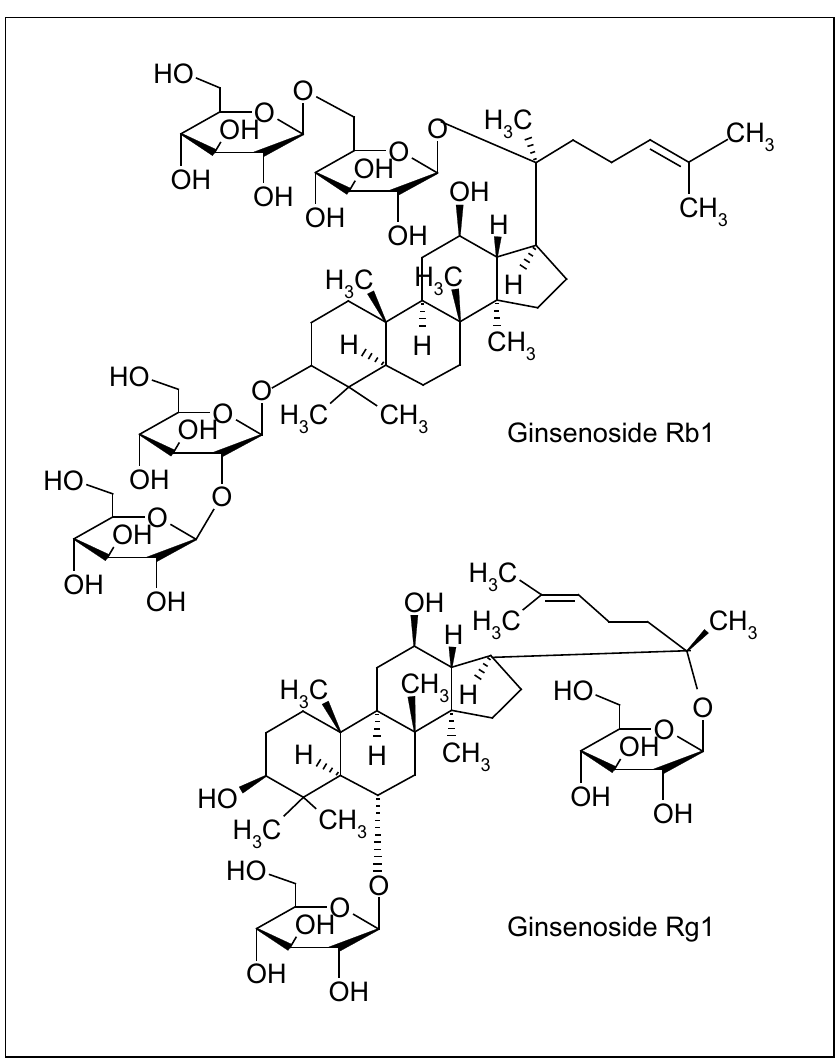
Figure 4. Ginsenosides of Panax ginseng C.A. Meyer root; Rb1 and Rg1 are characterized by different aglycones, protopanaxadiol and propanaxatriol,